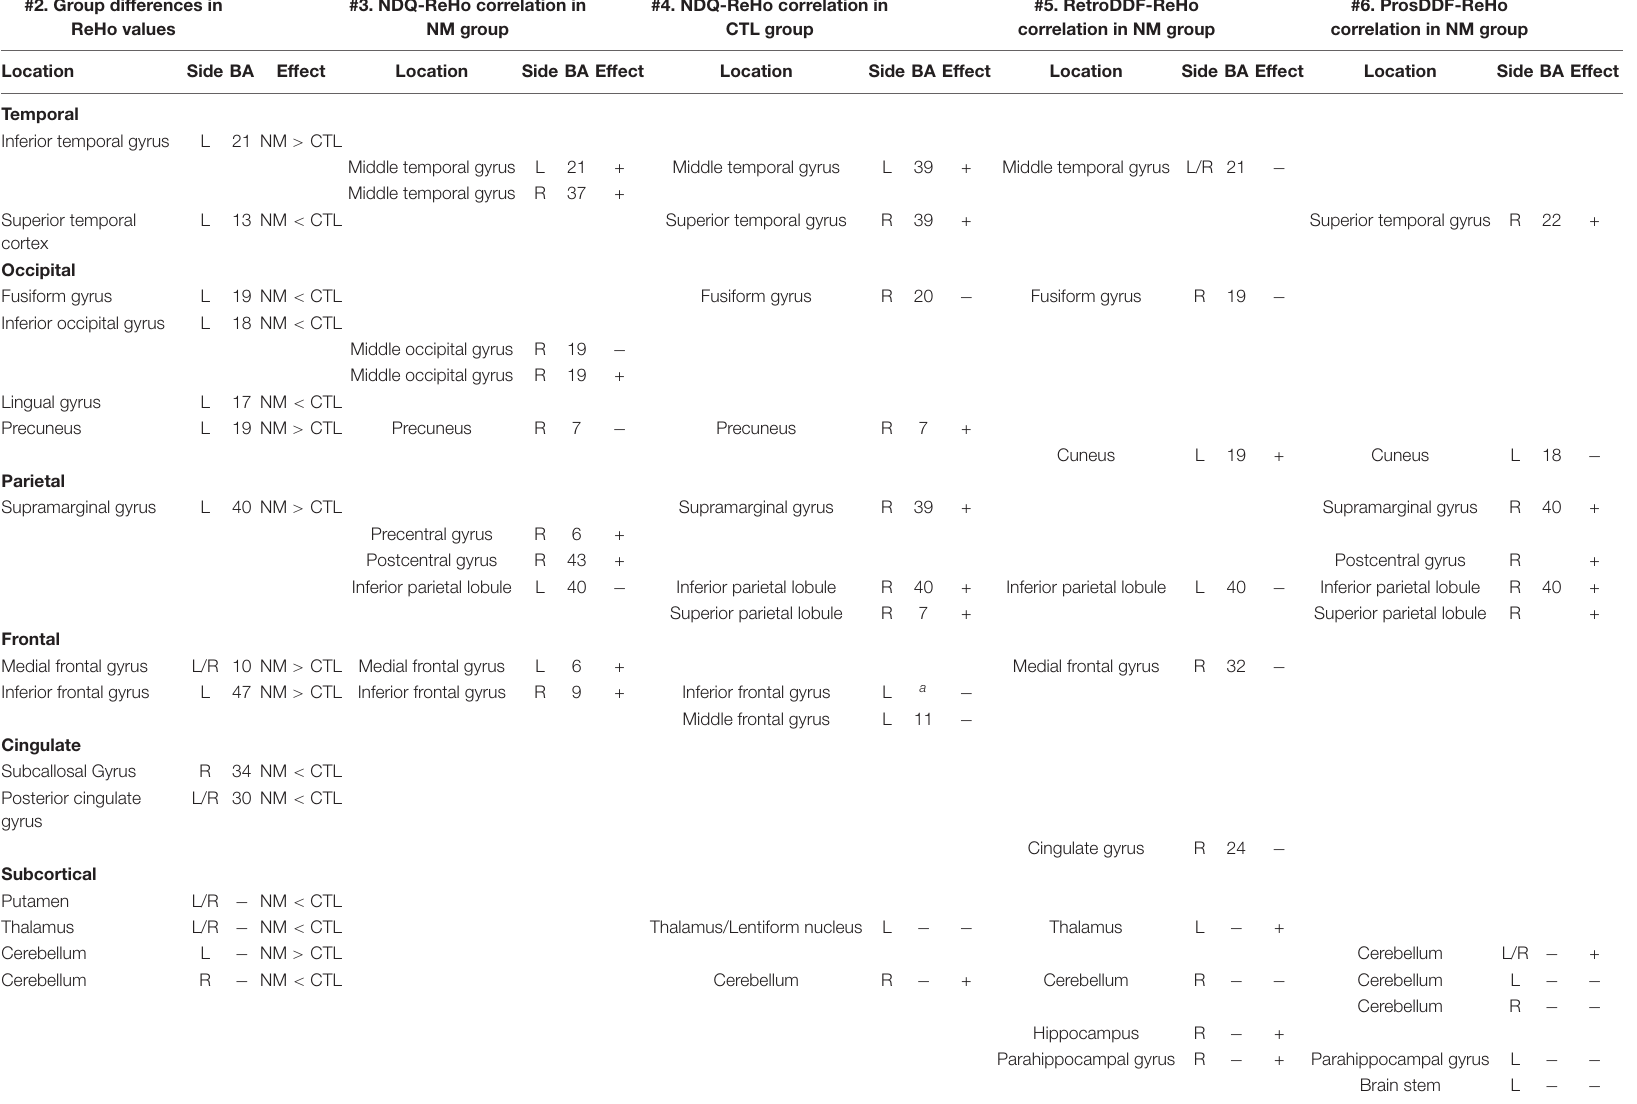
TABLE 7 | Summary of regions showing group differences in ReHo values and/or a correlation with ReHo values. #2. Group differences in ReHo